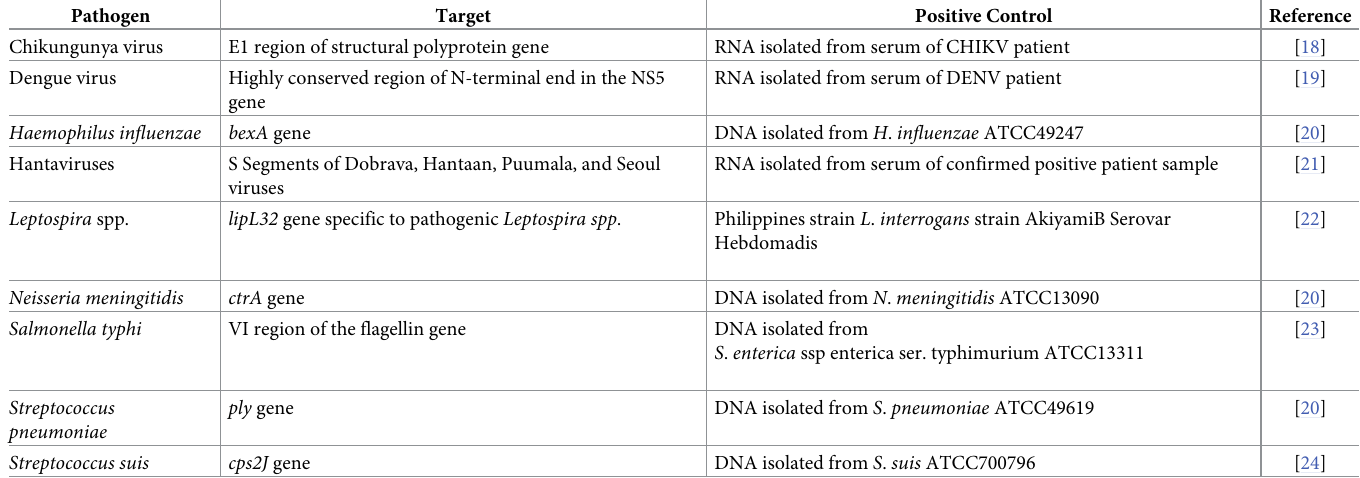
Table 1. Molecular Detection of Pathogens. Pathogens targeted for molecular detection are listed in the first column. The specific gene targets are listed in the next col- umn followed by the source of the positive control utilized in the reaction. Finally, the references from which the assays were derived are listed in the last column.